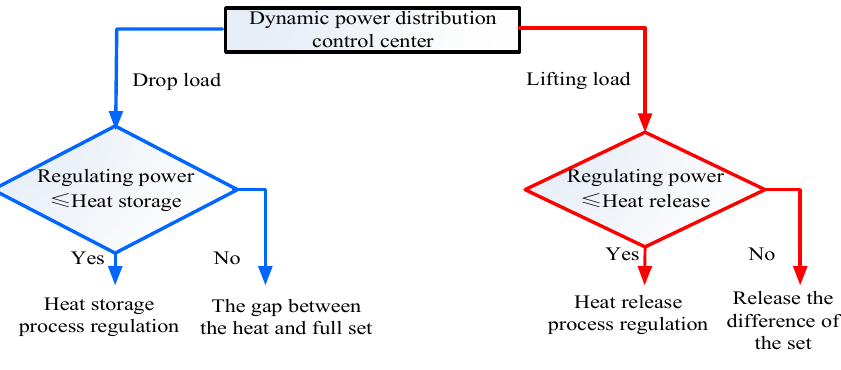
Figure 3. Dynamic power distribution control strategy.